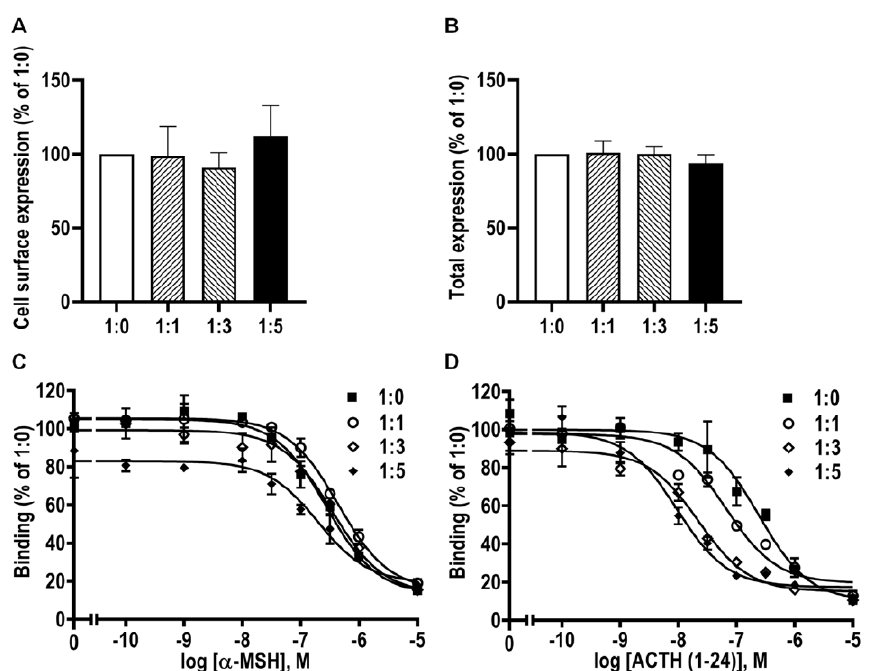
Figure 10. Modulation of caMC4R expression and binding properties by caMRAP2. HEK293T cells were co-transfected with caMC4R/caMRAP2 in four different ratios (1:0, 1:1, 1:3, and 1:5). Cell surface ( A ) and total ( B ) expression levels of caMC4R were measured by flow cytometry. Ligand binding experiments ( C , D ) were performed as in Figure 7. The results, calculated as percentage of 1:0 group, were expressed as the mean ± SEM of at least three independent